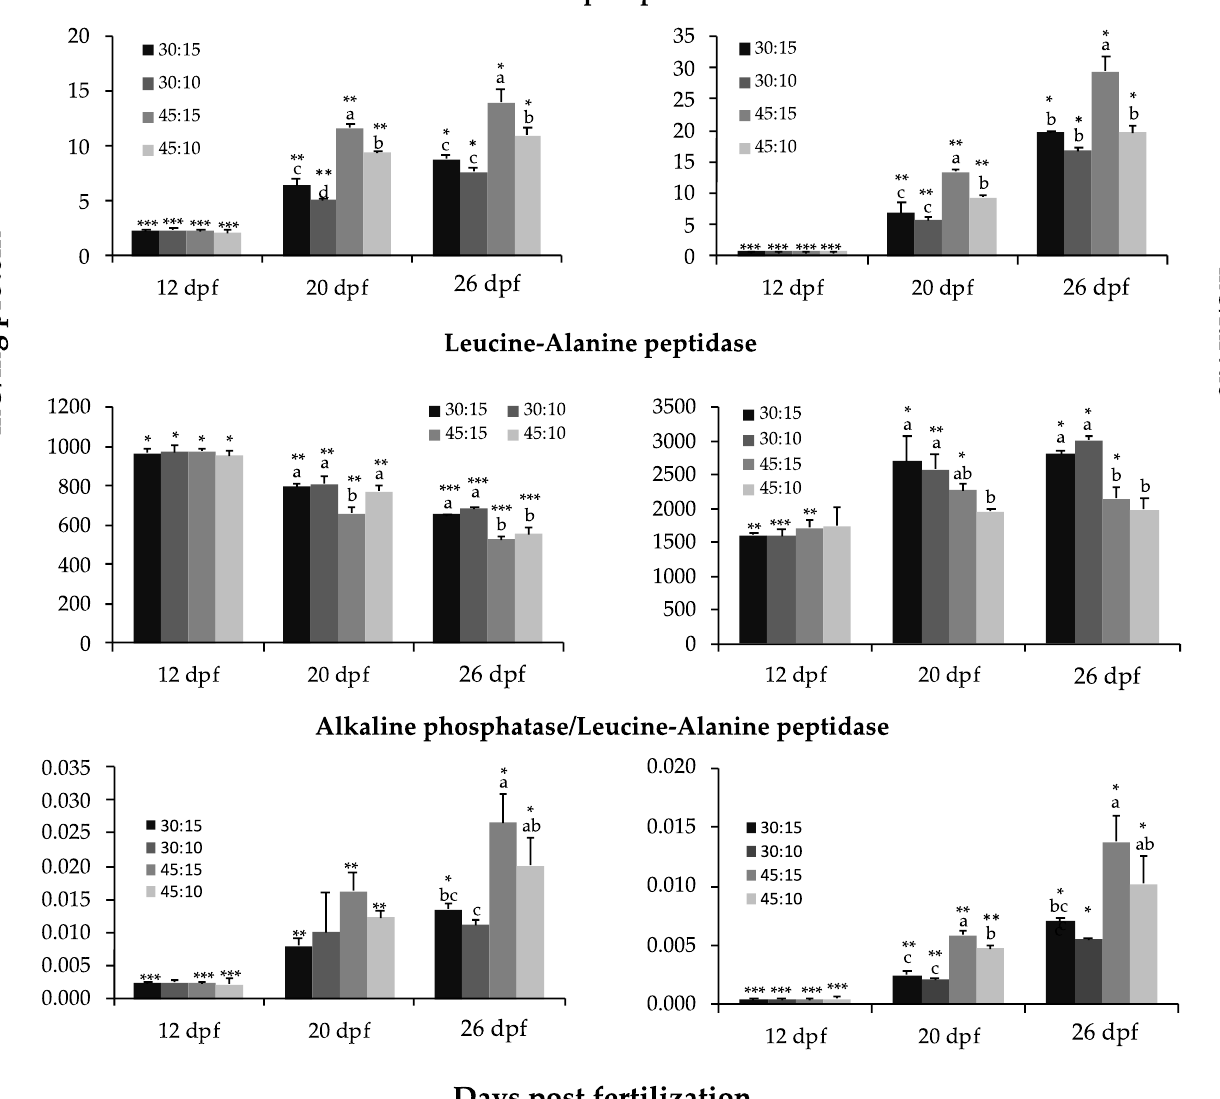
Figure 3. Specific (mU mg − 1 protein, on the left) and total (mU larva − 1 , on the right) activity of brush border (alkaline phosphatase) and cytosolic (leucine–alanine peptidase) intestinal enzymes and the ratio alkaline phosphatase to leucine–alanine peptidase ratio in P. punctifer (12, 20, and 26 dpf) fed the different experimental diets containing different protein:lipid levels (in % of dry matter). Data are represented as means ± S.D. ( n = 3). Values with a different superscript letter denote significant differences between dietary groups of the same age, and values with a different number of asterisks indicate significant differences between days for the same dietary treatment (one-way ANOVA, p < 0.05).